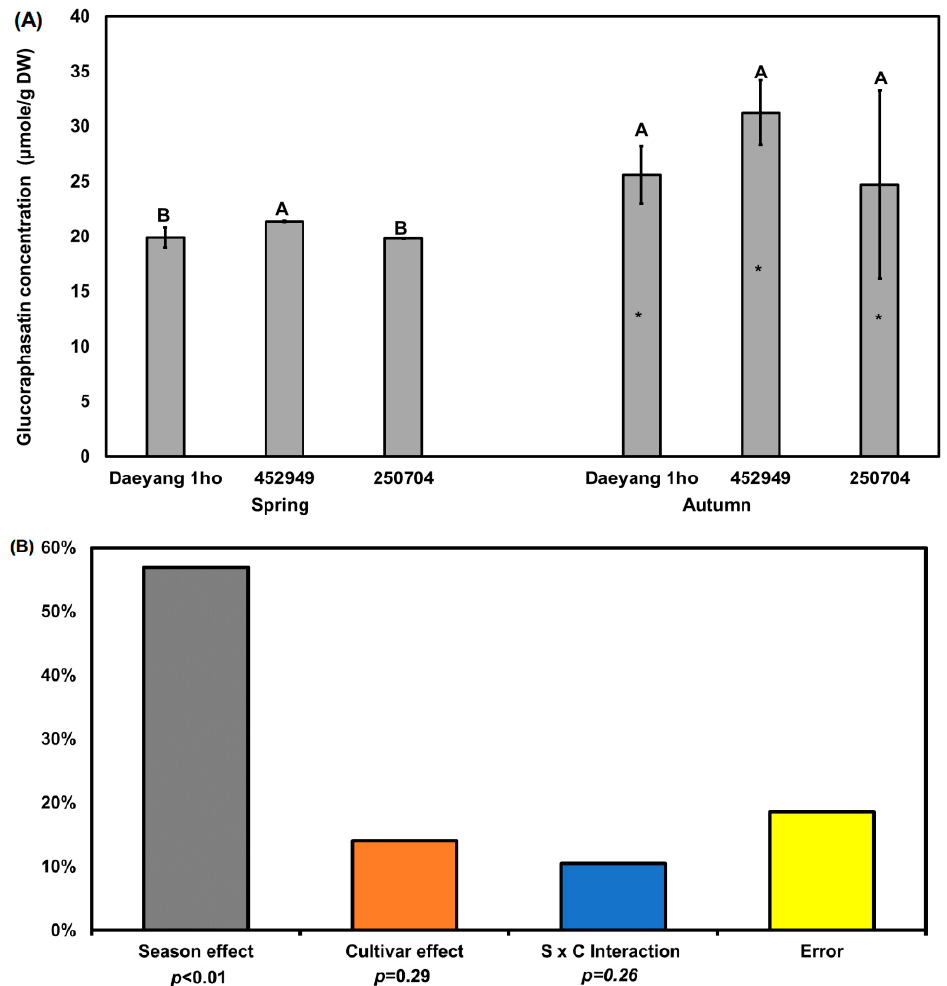
Figure 2. ( A ) Glucoraphasatin content in the roots of three different radish cultivars grown in spring and autumn 2020. Different capital letters above the error bars indicate significant differences among cultivars within the same season according to Tukey’s HSD test ( p < 0.05). Asterisks (*) inside the bars indicate significant differences between spring and autumn within the same cultivar according to an unpaired Student’s t -test ( p < 0.05); ( B ) Two-way ANOVA for glucoraphasatin content in radish roots of three different cultivars across two seasons. S × C indicates the interaction of season and cultivar. % indicated % of explained variation.